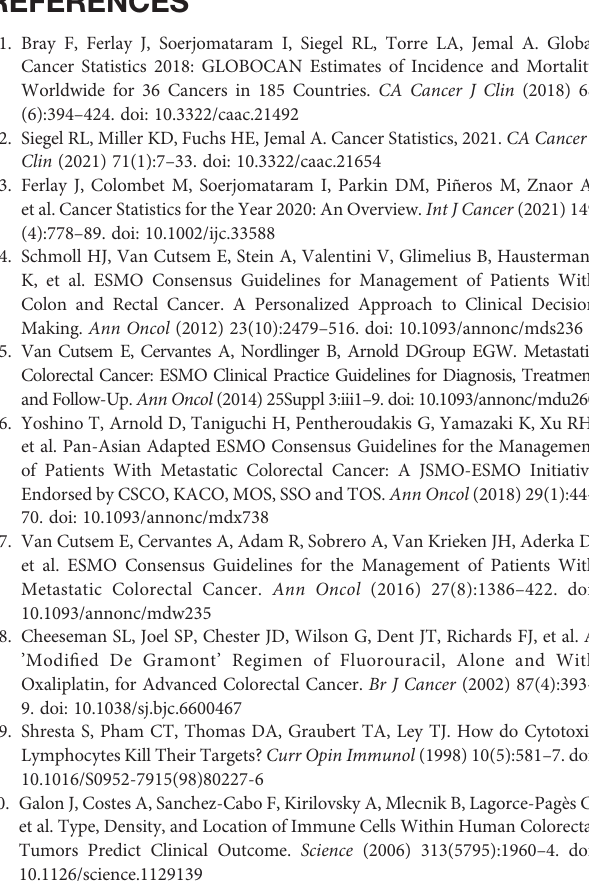
into BALB/c mice (5x10 5 in s.c.), treated or not by H89 (10 mg/kg, i.p. injection two times a week). Control group received NaCl injection. (n=10 mice/group). Statistical analyses were performed using a t-test. Supplementary Figure 3 | Heatmap showing differential gene expression and GSEA Hallmark pathways variation in response to H89. RNAseq analyses for gene expression (A) and GSEA Hallmark pathways variation (B) were performed on colorectal tumors from BALB/c mice treated or not with H89 at D14 after CT26 cancer cells injection (n=3 mice/group). Statistical analyses were performed using the DESeq2 package using a Wald test . GSEA was conducted using clusterPro fi ler R package. Supplementary Figure 4 | Flow cytometry dot plot representation of effector memory CD8+ T cells at D14 after H89 treatment. Representation of the gating strategy on CT26 tumors treated with H89 at D14 (10 mg/kg, i.p., NaCl in the control group) for the identi fi cation of effector memory (EM) CD8 T cells. EM CD8 T cells are highlighted in the red frame. Supplementary Figure 5 | Flow cytometry dot plot representation of CD8 +/GranzymeB+ CD8 T cells at D14 after H89 treatment. Representation of the gatingstrategy onCT26 tumors treatedwith H89at D14(10mg/kg, i.p., NaCl inthe control group) for the identi fi cation of Granzyme B+ CD8 T cells which are highlighted in the red frame. Supplementary Figure 6 | Flow cytometry dot plot representation of Th1 and Treg cells at D14 after H89 treatment. Representation of the gating strategy on CT26 tumors treated with H89 at D14 (10 mg/kg, i.p., NaCl in the control group) for the identi fi cation of Th1 and Treg cells which are highlighted in the red